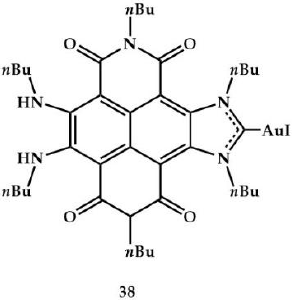
Figure 16. Complex 38 of Peris et al. [33].